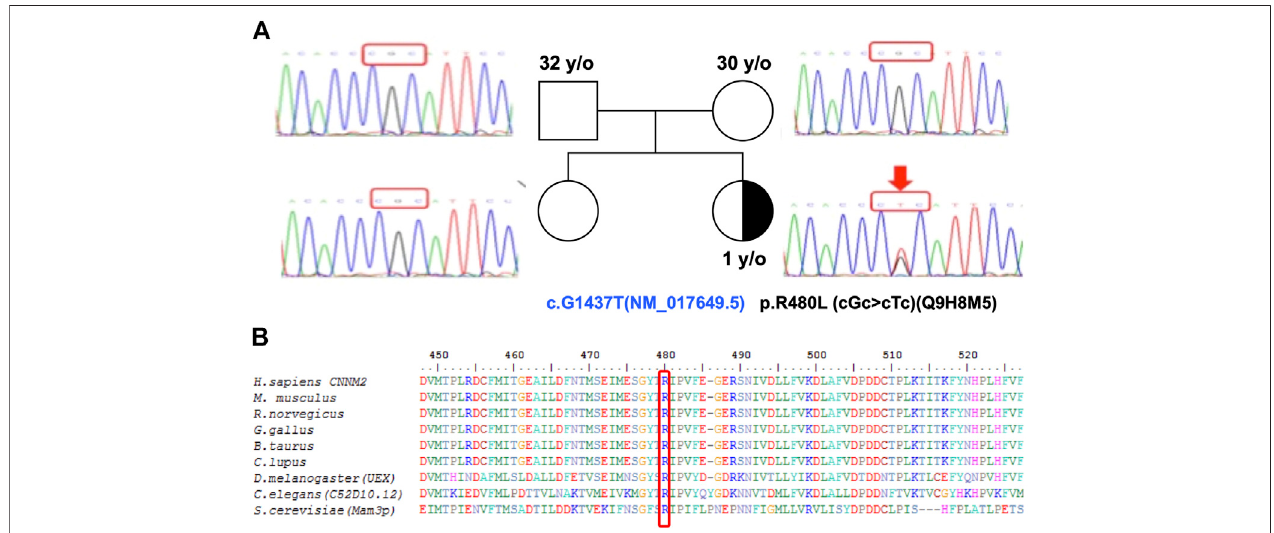
FIGURE2 | A multiple sequence alignmentshows R480 asa highly conserved residue. (A) Pedigree showing the index patientand her parentswith heterozygous CNNM2 mutation with a half- fi lled black symbol. (B) The R480 of CNNM2 is a highly conserved amino acid (Stuiver et al., 2011). The sequence accession IDs are H. sapiens : Q9H8M5, M. musculus : Q3TWN3, R. norvegicus : Q5U2P1, G. gallus : K7CZV7, B. taurus : A0A3Q1LRB9, C. lupus : E2RJ19, D. melanogaster (UEX) : A0A0B7P9G0, C. elegans (C52D10.12) : A3QM97, and S. cerevisiae (Mam3p) :